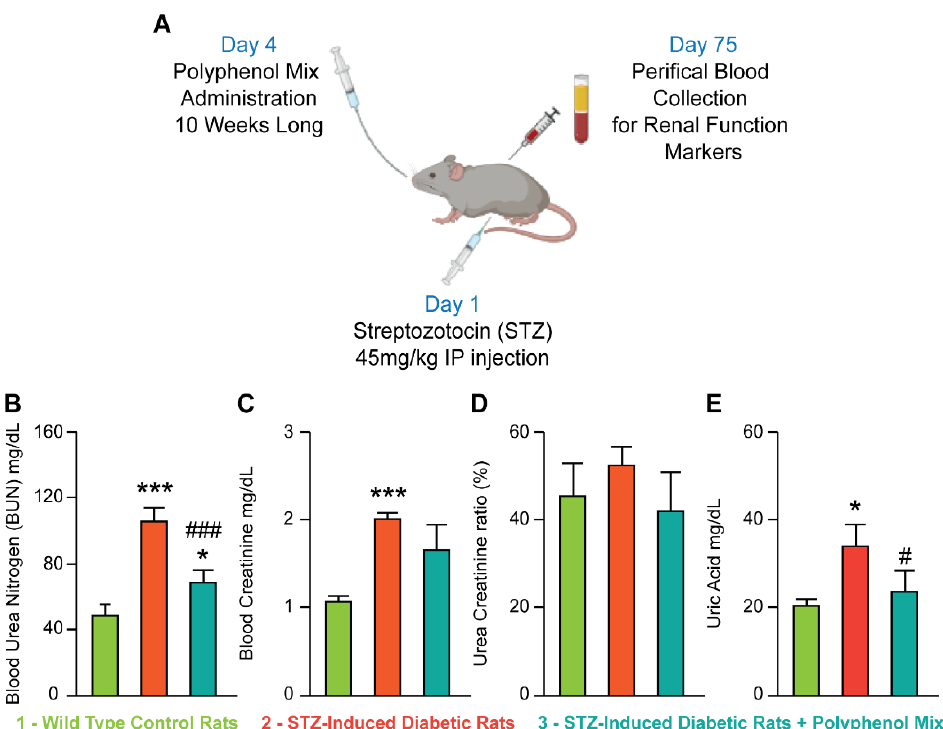
Figure 1. Diabetes induction model with STZ for exploring the renal protective effects of polyphenol mix. ( A ) Illustration of the study design. ( B – E ) Hematological parameters of urea, creatinine, urea creatinine ratio and uric acid of control, STZ-induced diabetic and treated rats with a combination of naringenic, chlorogenic acid, and quercetin (NCQ). Graphical synthesis of experimental STZ-induced diabetic rats was created with BioRender.com. Data are presented as means ± SEM. * p < 0.05, *** p < 0.001 indicate significant difference when the STZ-induced diabetic rats is compared to control group. # p < 0.05, ### p < 0.001 indicate statistical difference when NCQ-STZ treated rats are compared to STZ group.